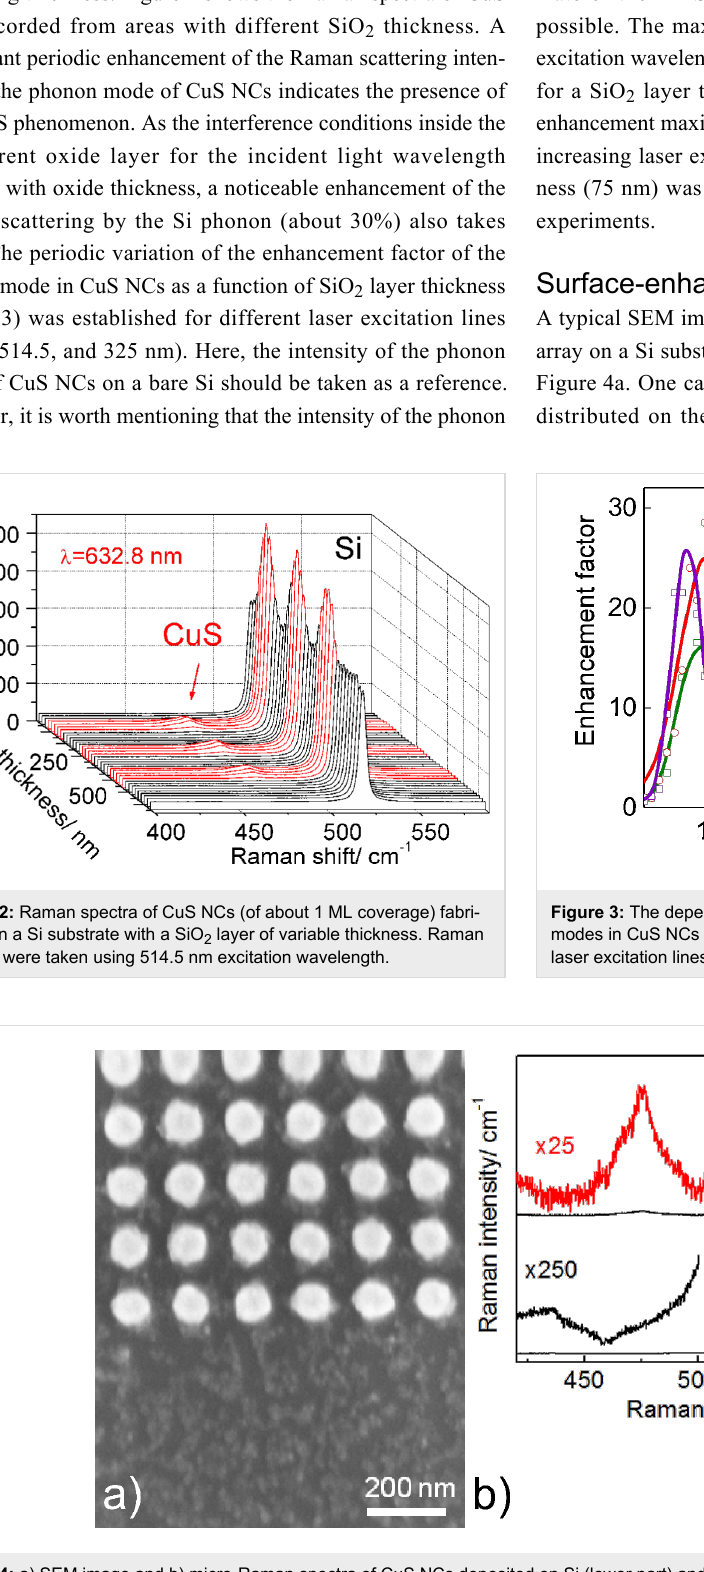
Figure 4: a) SEM image and b) micro-Raman spectra of CuS NCs deposited on Si (lower part) and Au nanocluster array (upper part).